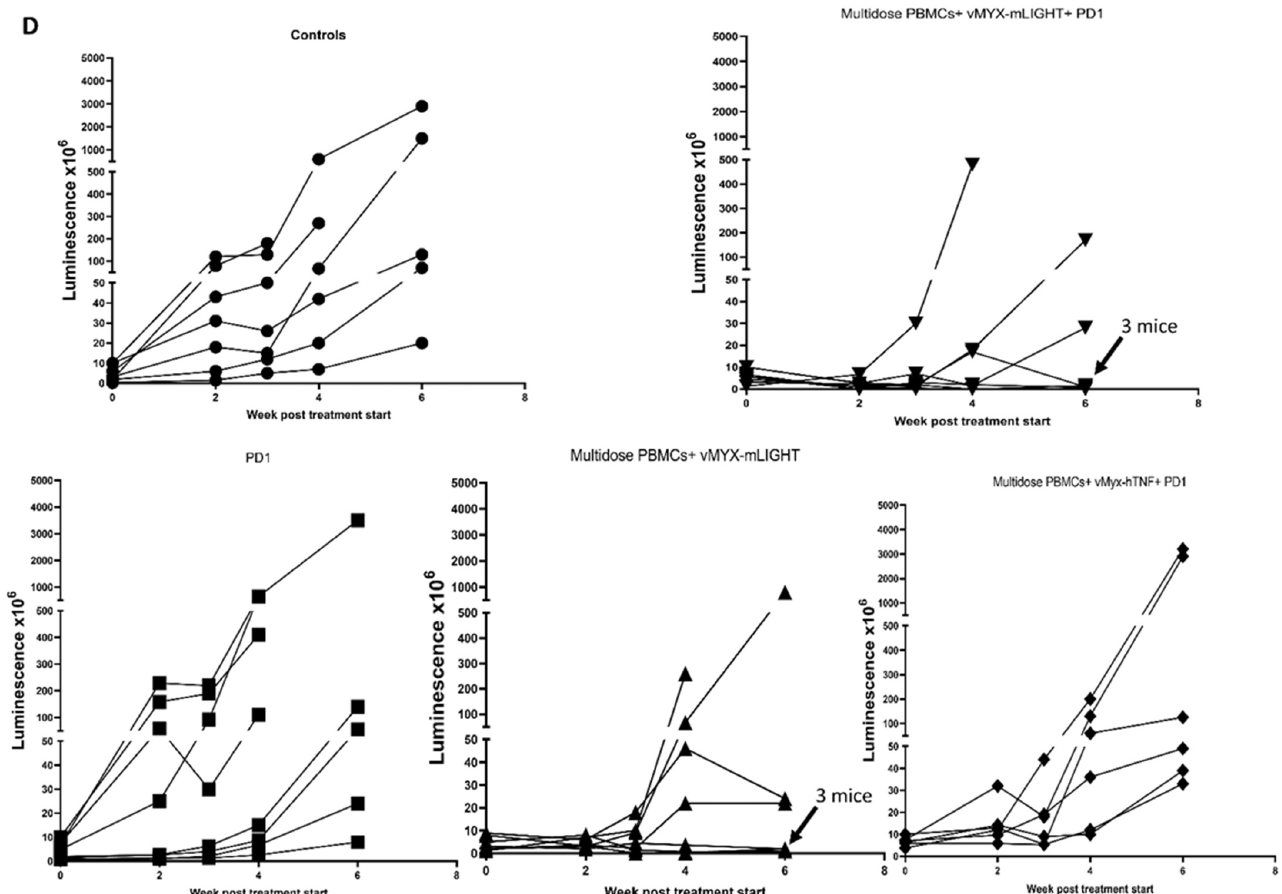
Figure 2. vMyx-mLIGHT/PBMC monotherapy and vMyx-mLIGHT/PBMC + anti-PD-1 combination treatment of animals with advanced late-stage K7M2-Luc lung tumors leads to increased tumor regression and improved mean survival. ( A ) Diagram of experimental setup. Balb/c mice were inoculated with K7M2-Luc cells at day 0 via IV injection of K7M2-luc cells. Treatment with anti-PD-1 started on day 21 when mean lung tumor luminescence had reached advanced late-stage disease criteria of 5 × 10 6 units per mouse lung and continued every 3 rd day for 4 total doses. Multi-dose treatment with vMyx-hTNF or vMyx-mLIGHT using ex vivo loaded PBMC carrier cells also started on day 21 and continued every 4 th day for four total virus/PBMC doses. ( B ) Kaplan–Meier survival curves comparing untreated controls, anti-PD1, vMyx-hTNF/PBMC + anti-PD-1 and vMyx-mLIGHT/PBMC + anti-PD-1. Animals treated with either vMyx-mLIGHT/PBMC or vMyx- mLIGHT/PBMC + anti-PD-1 survived significantly longer than animals treated with monotherapy anti-PD-1 or combination vMyx-hTNF/PBMC + anti-PD-1. ( C ) Representative luminescence images are shown at treatment start date (day 21) and 4 weeks post-treatment start date (day 49), ( i , ii ) show untreated K7M2-luc tumor-bearing controls and ( iii , iv ) showing vMyx-mLIGHT/PBMC + anti-PD-1 treated animals. ( D ) Line graphs showing individual mouse tumor luminescence progression over the first 6 weeks post-treatment start (9 weeks after K7M2-luc